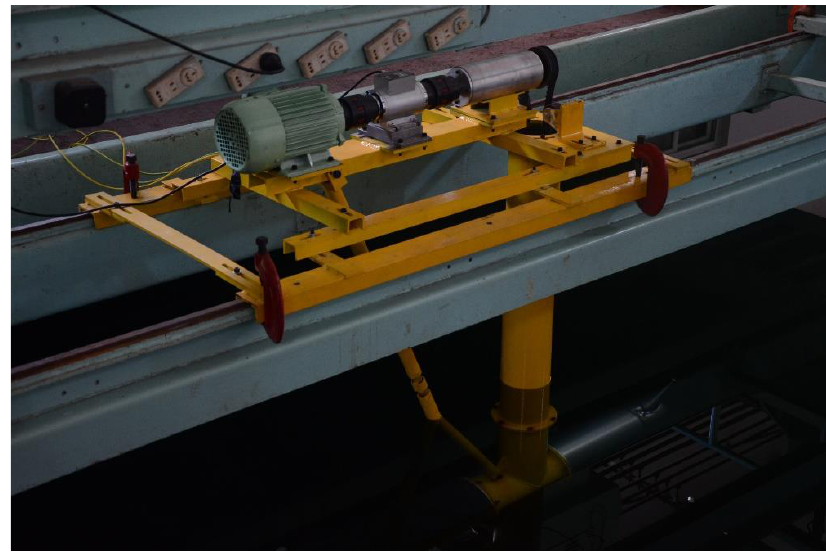
Figure 3. The test device.